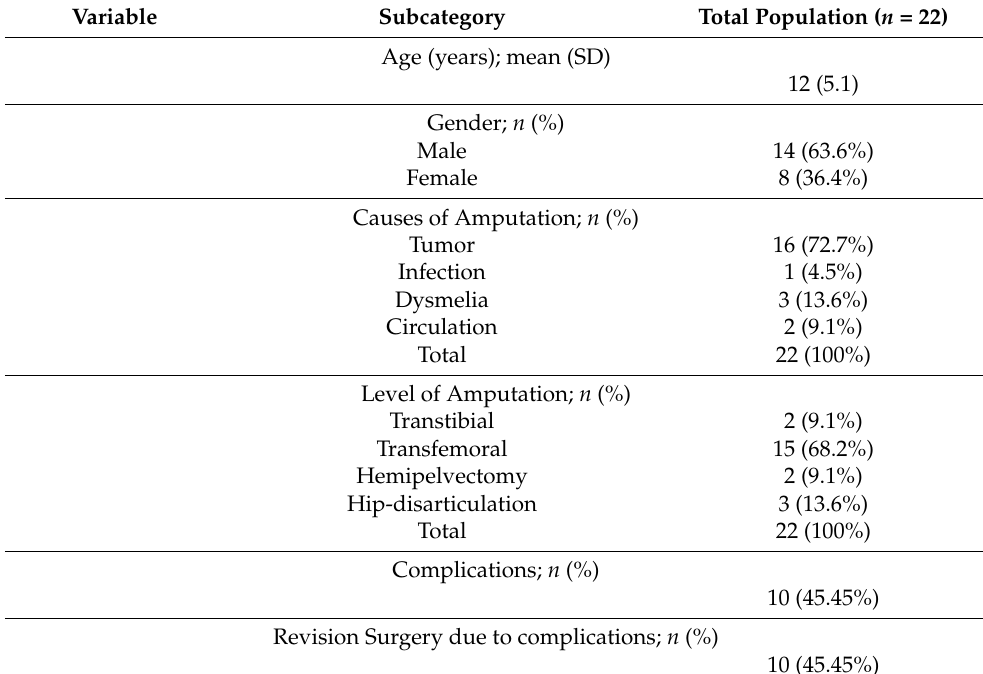
Table 1. Demographic and clinical characteristics of included children/adolescents with lower- extremity amputation ( n =